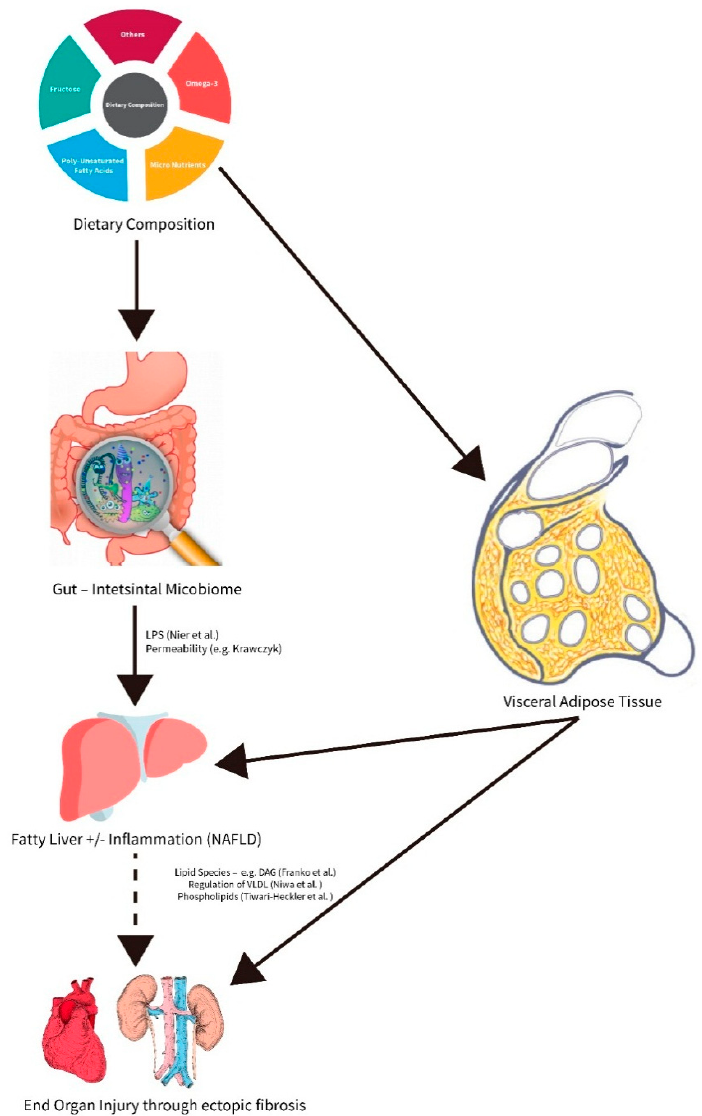
Figure 1. Role of macro- and micronutrients in affecting hepatic and extrahepatic inflammation and fibrosis during the progression of non-alcoholic fatty liver disease (NAFLD).